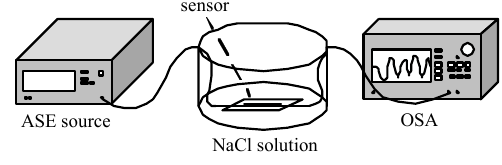
Fig. 8 Refractive index sensing experimental system.